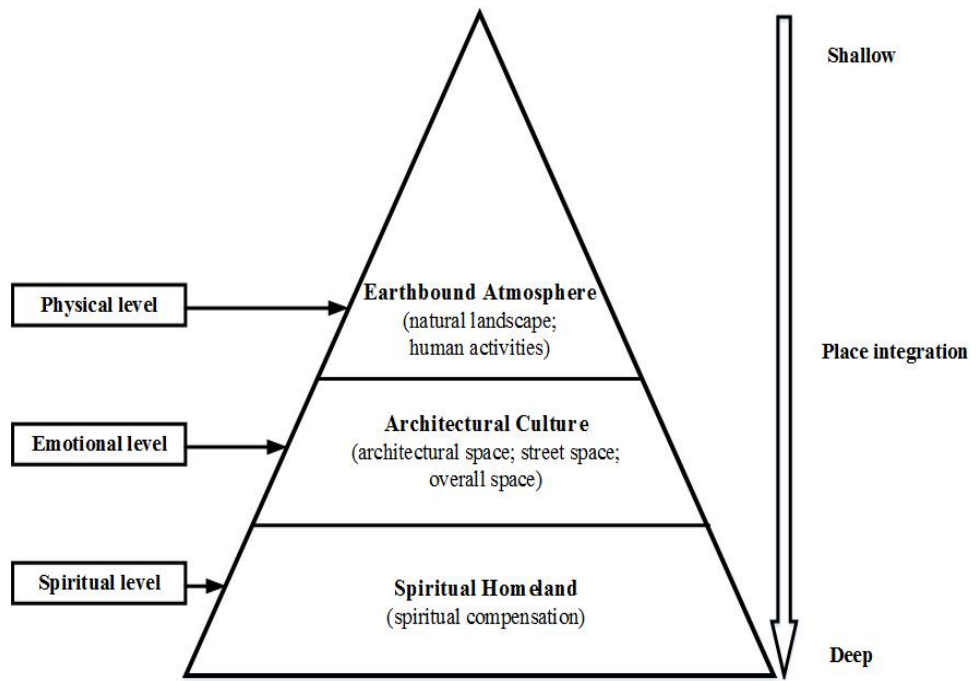
Figure 4. The model of genius loci in an ancient village.